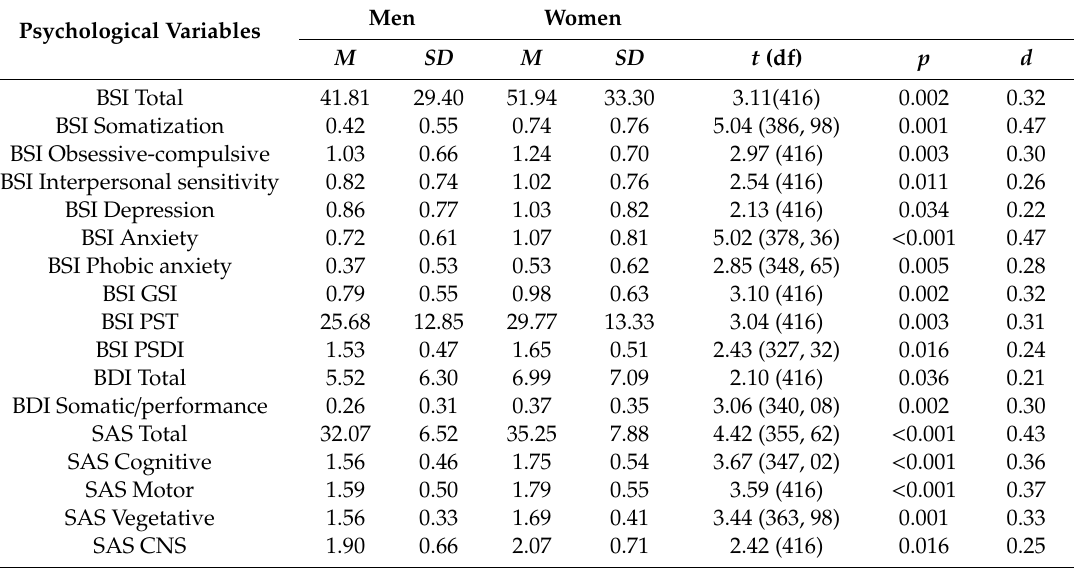
Table 4. Significant means di ff erences of